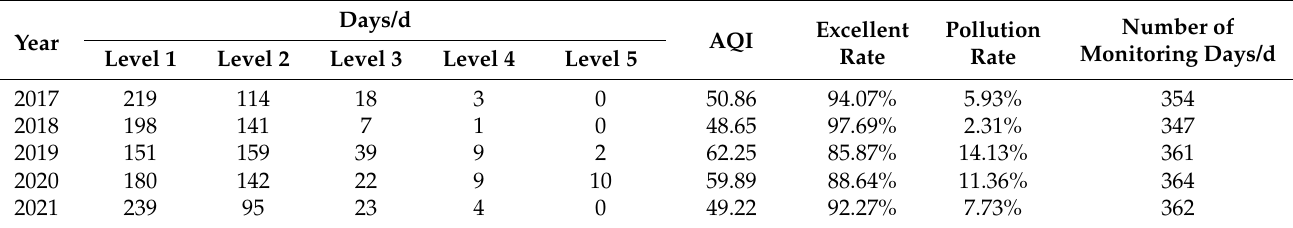
Table 1. Statistics for Jinghong’s AQI level days from 2017 to 2021.